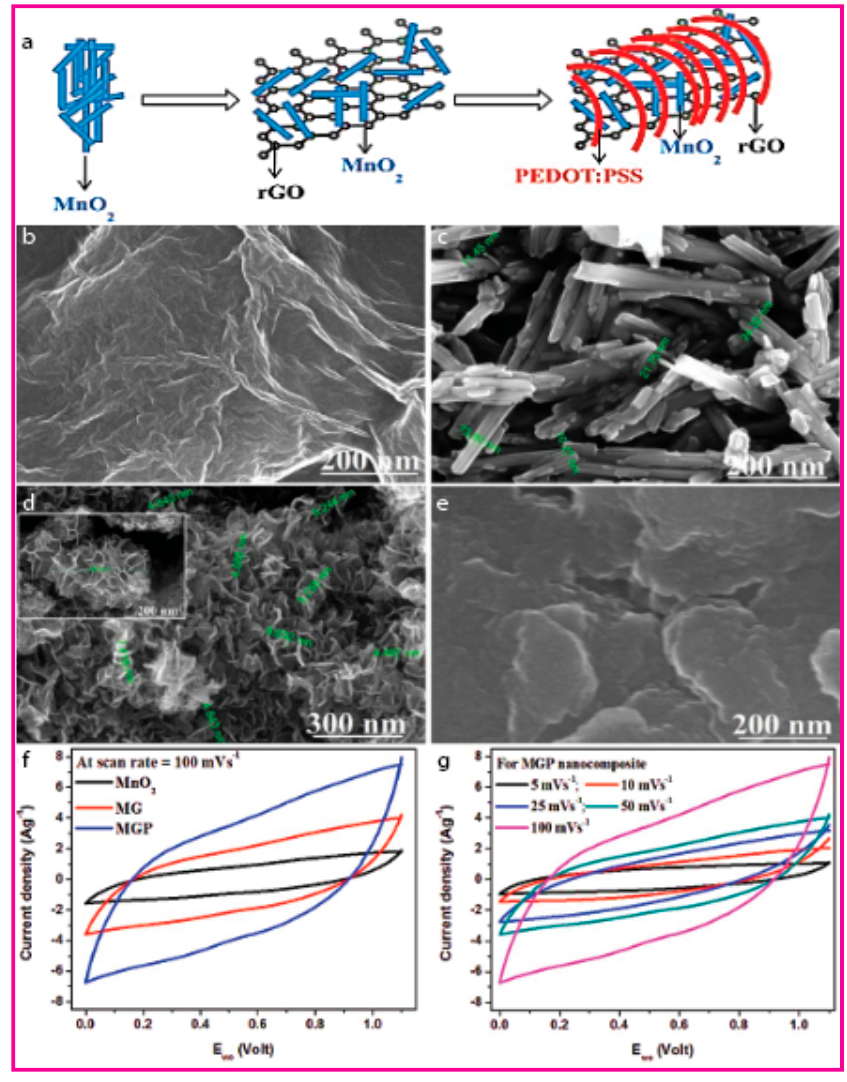
Figure 19. ( a ) The presentation of the MGP nanocomposite fabrication. The FESEM images of ( b ) GO, ( c ) MnO 2 nanorods, ( d ) MG nanocomposite and ( e ) MGP nanocomposite. The CVs of ( f ) all the electrode material samples at a scan rate of 100 mV · s − 1 and ( g ) the MGP nanocomposite at various scan rates. Reprinted with permission from [388], Copyright 2017, Royal Society of Chemistry.